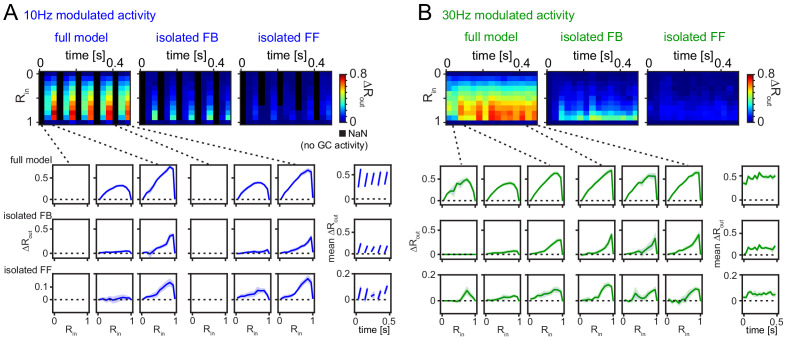
Robustness for shorter analysis time-window.(A) 33 ms time-resolved pattern separation effects of the full model, isolated feedback (FB) or feedforward (FF) inhibition for theta modulated input (10 Hz). All analyses were performed as above but with rate vector correlations computed for 33 ms time windows (instead of 100 ms or 600 ms, as in Figure 6). The bottom insets show ΔRout as a function of input similarity for the first and last three time windows. The bottom right insets show the evolution of the mean ΔRout over time. (B) Same as (A) but for slow gamma (30 Hz) modulated inputs. Data represent mean ± SEM of n = 7 random network seeds.